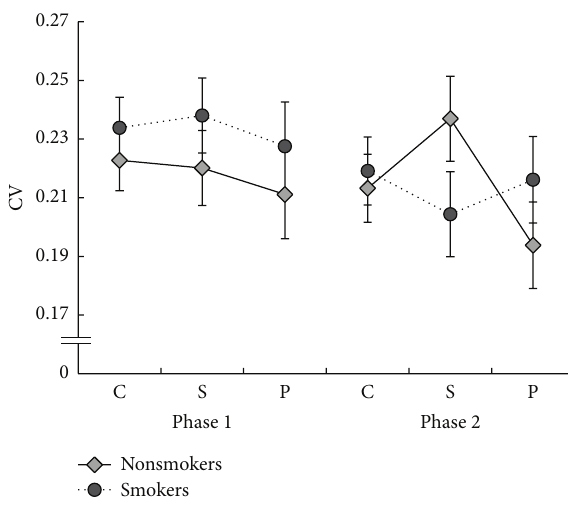
Figure 3: CV and SEM for all conditions (c, s, and p) for nonsmokers and smokers in phases 1 and 2 of the